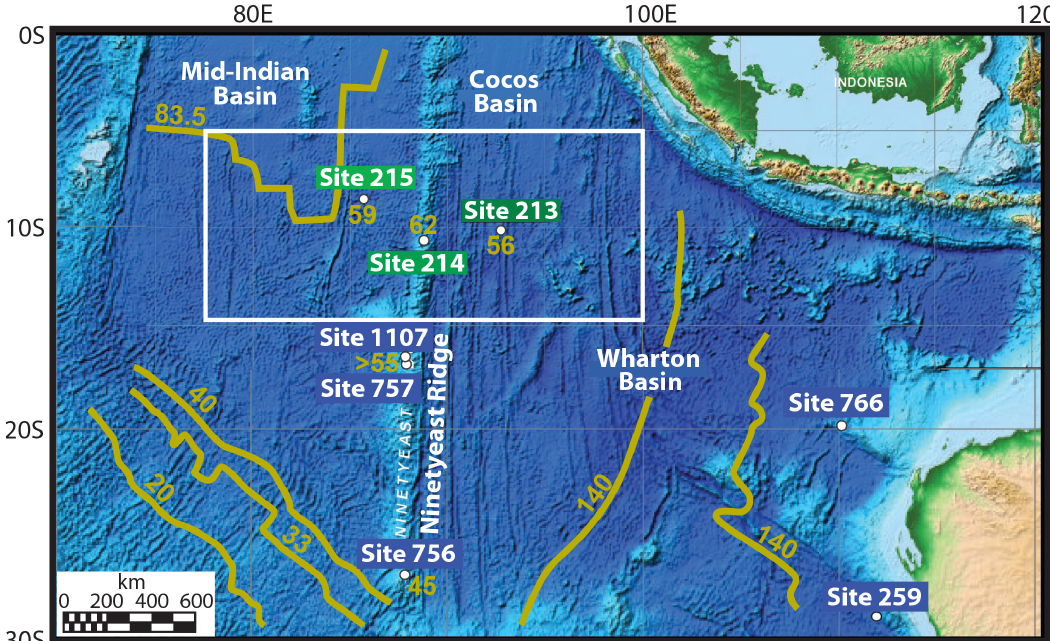
Figure 2. Modern bathymetric map of the northeastern Indian Ocean with the area of interest (white rectangle). Locations of Sites 213, 214, and 215 are labeled with green boxes. Five additional and relevant site locations are denoted in blue boxes. Ages marked along Ninetyeast Ridge are derived from Frey et al. (2011). Other seafloor ages, also on a million-year timescale, are marked by yellow-green numbers. The open white rectangle indicates the specific area of